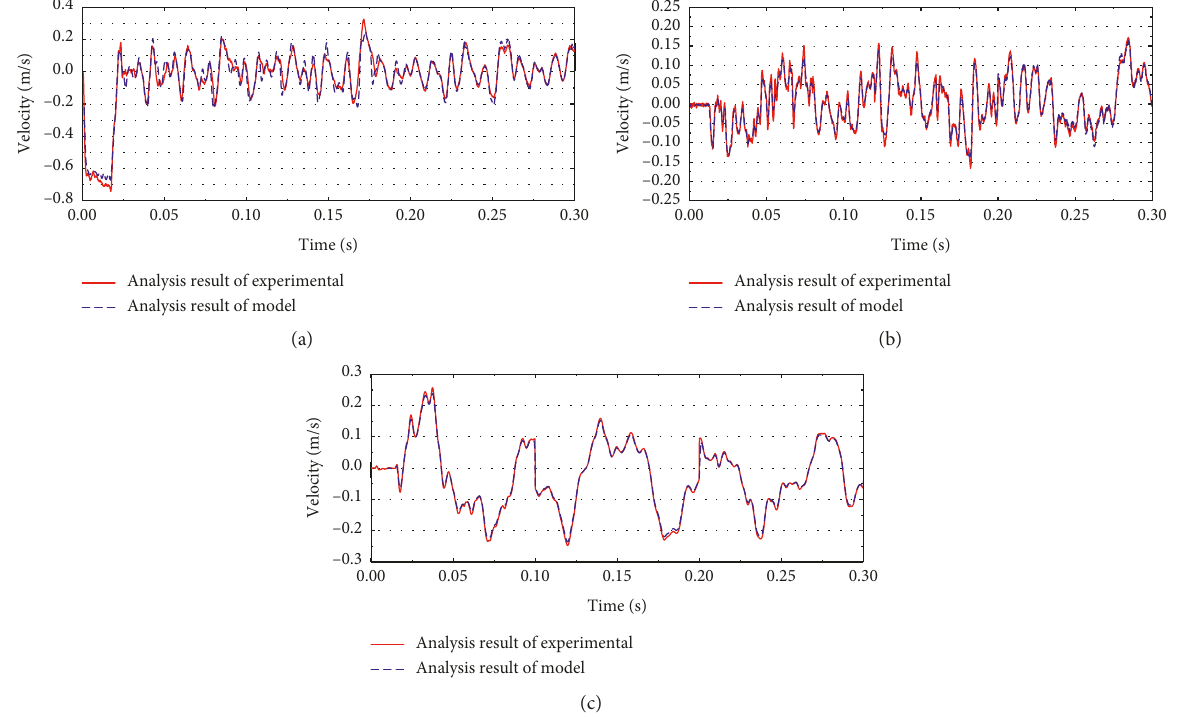
Figure 12: Variation of tubing wall velocity with time in gas injection. (a) Vertical well section. (b) Inclined well section. (c) Horizontal section.